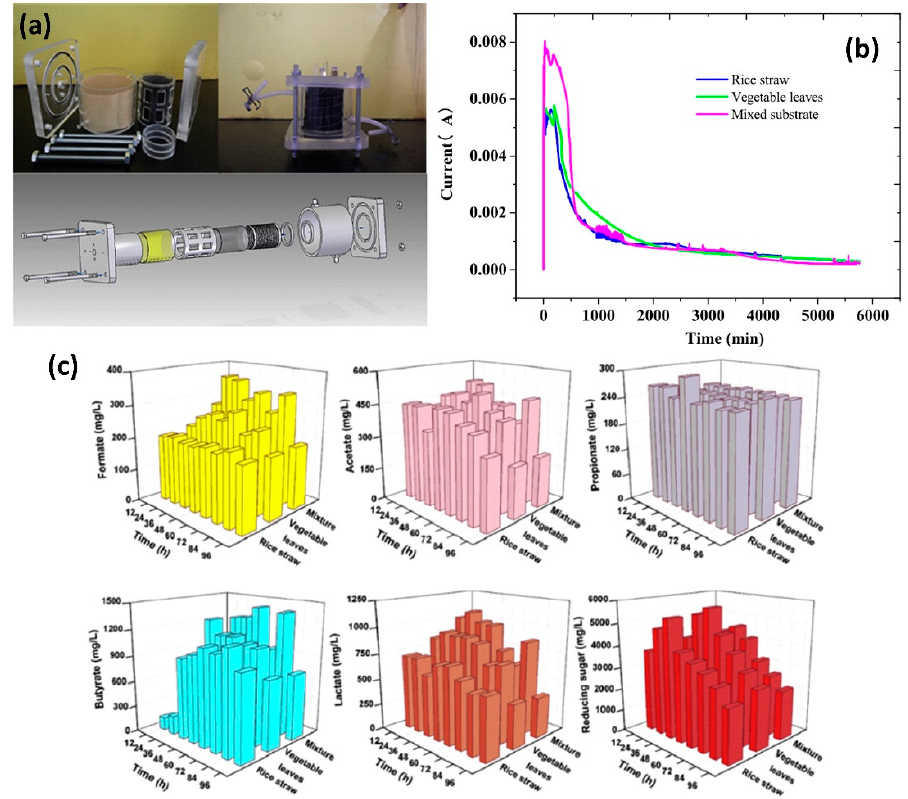
Figure 6. ( a ) The configuration of an MEC reactor. ( b ) The present manufacturing in MEC systems. ( c ) The consequence of various substrates on the intermediates of an MEC system. (Reprinted with permission from [55]. Copyright 2019, Elsevier.) Table 2. Modifications of MECs for hydrogen production.